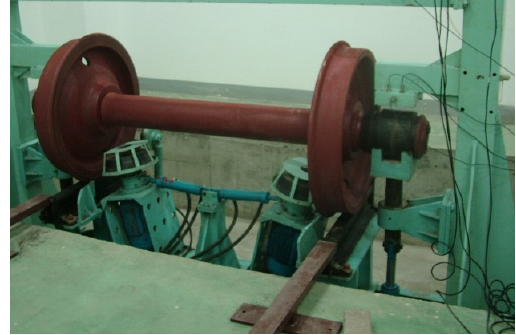
Figure 8. The test rig of wheelset bearing.